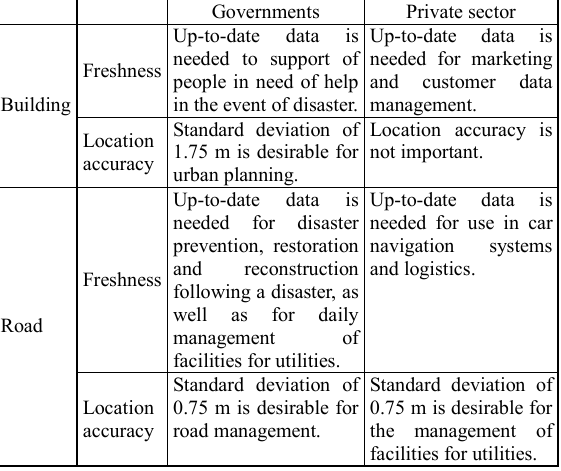
Table 1. Required quality of building and road data from the